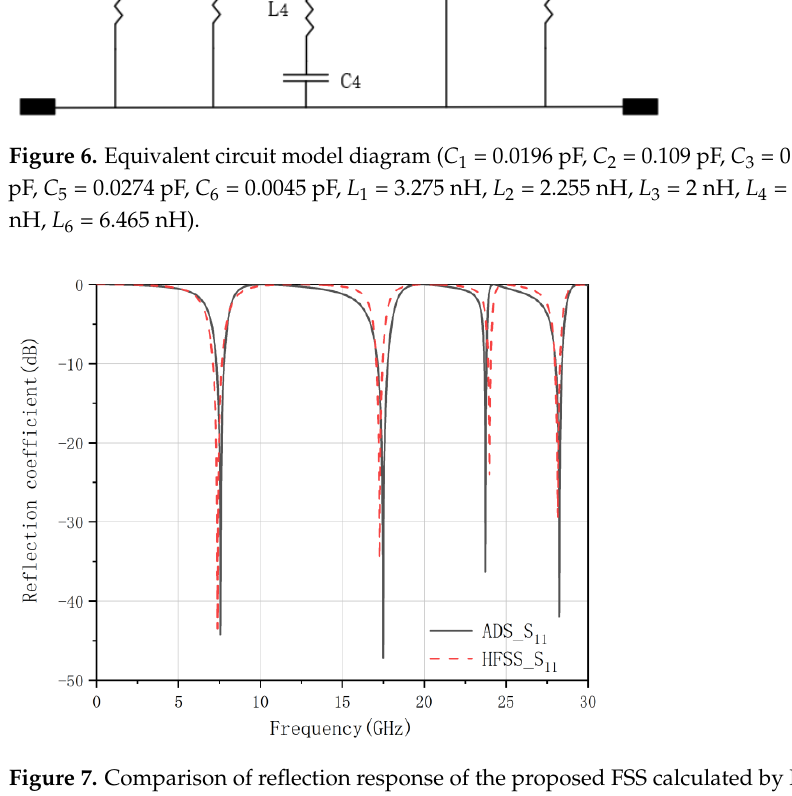
Figure 7. Comparison of reflection response of the proposed FSS calculated by HFSS and ADS.